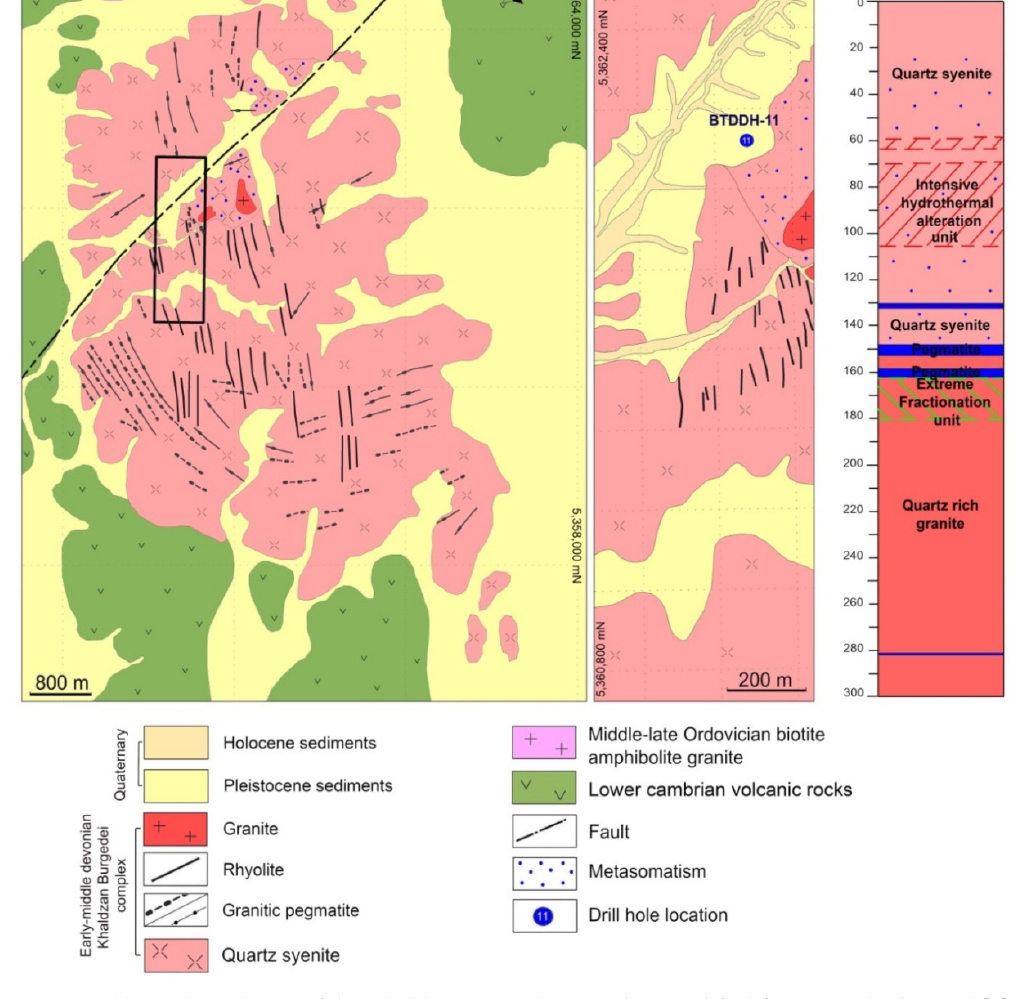
Figure 2. ( a ) Geological map of the Khaldzan Burgedei complex, modified from Kovalenko et al. [5], ( b ) Detailed map of the study area, and ( c ) BTDDH-11 drill hole core section.